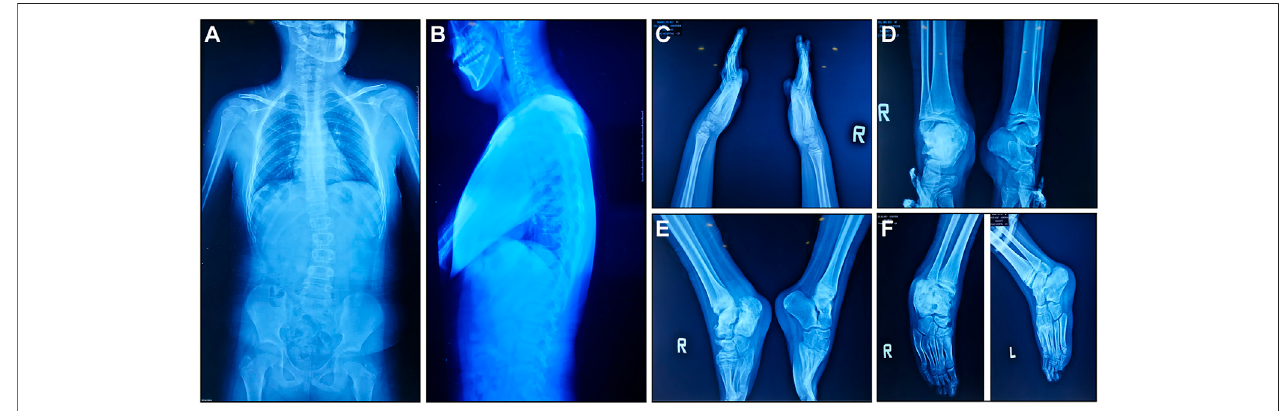
FIGURE 1 | X-ray manifestations of the recruited CIPA patient. (A,B) Front and side images of the torso. (C) Hands and wrists. (D – F) Ankles in different